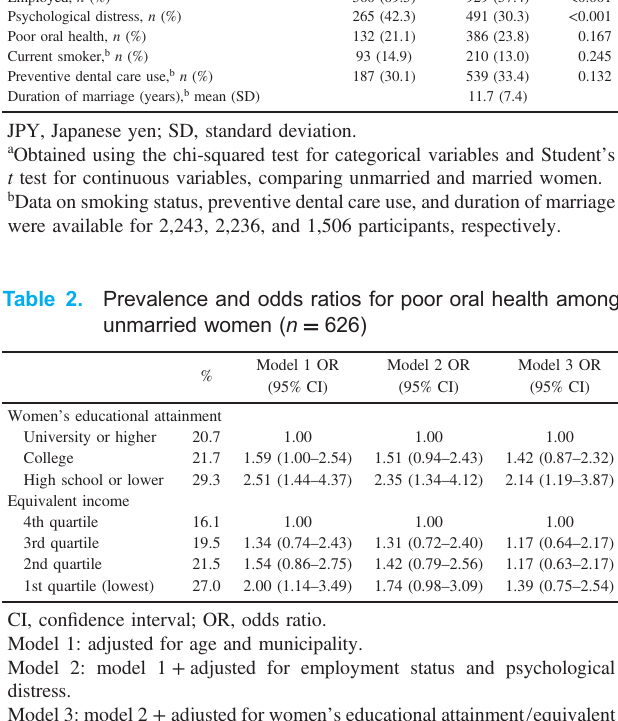
CI, con fi dence interval; OR, odds ratio. Model 1: adjusted for age and municipality. Model 2: model 1 + adjusted for employment status and psychological distress. Model 3: model 2 + adjusted for women ’ s educational attainment = equivalent income.